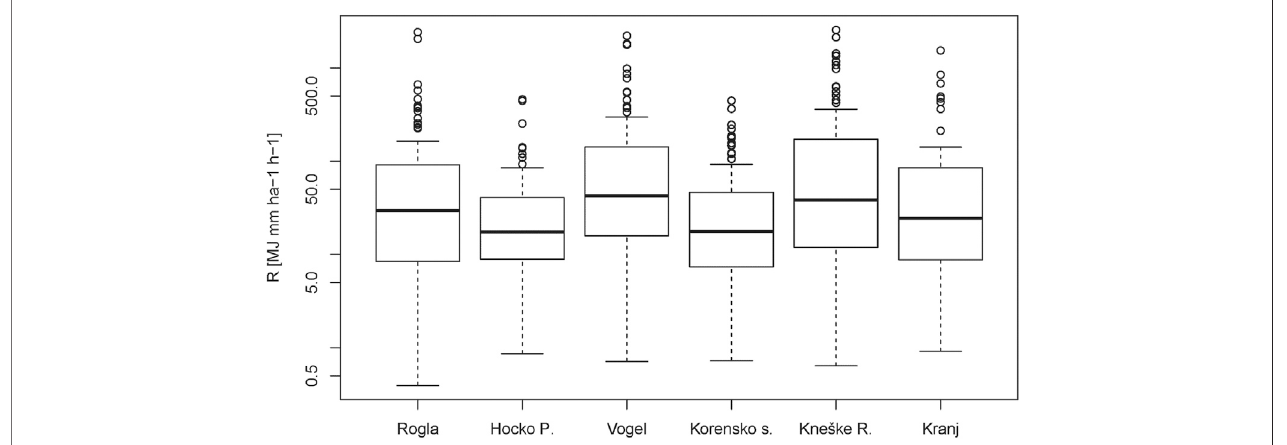
FIGURE 8 | Boxplots of all erosive events for the analyzed stations, where rainfall erosivity was calculated using 1 min optical disdrometer data.